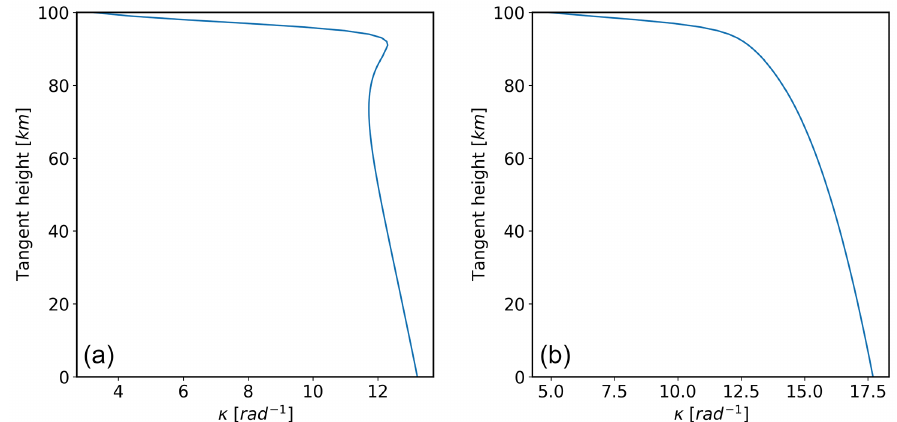
Figure 5. Estimate of κ for test 1 ( a , midday) and test 2 ( b ,